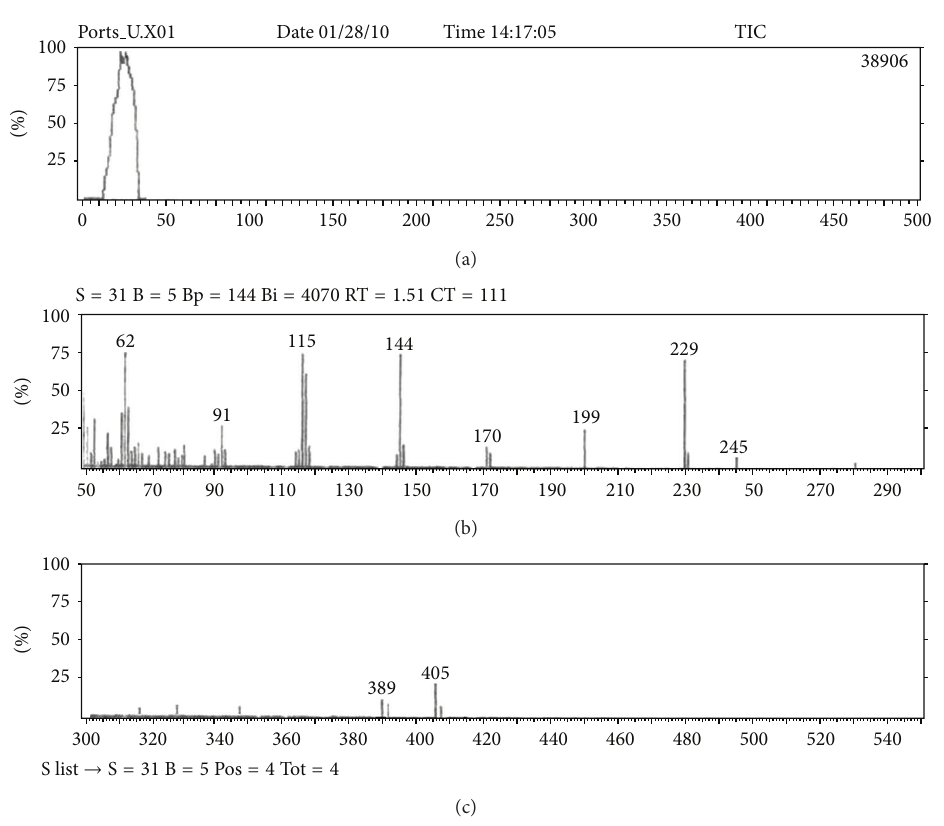
Figure 2: Mass spectrum of naphtalene-1,4-diol and styphnic acid complex.